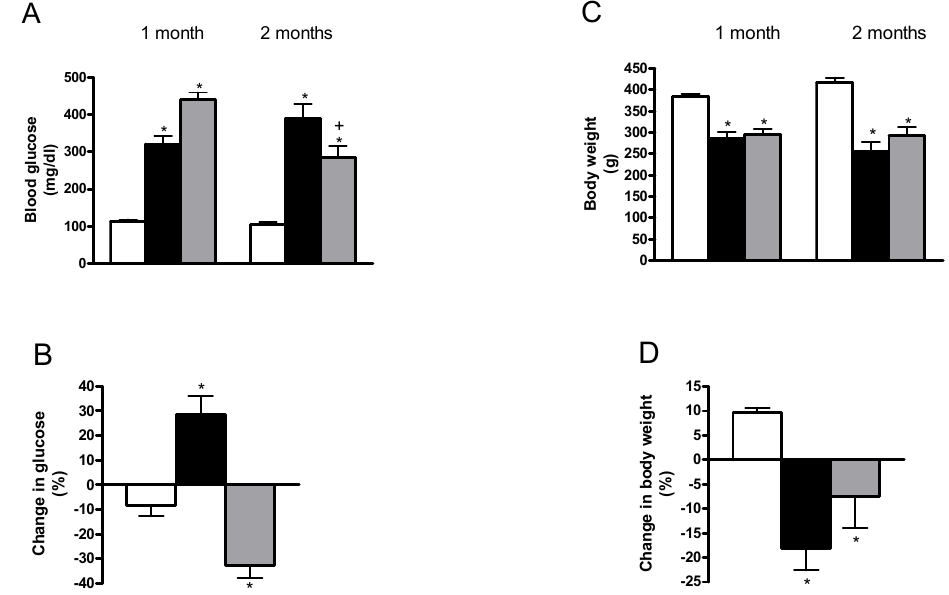
Figure 1. Comparisons of blood glucose ( A , B ) and body weight ( C , D ) for the control, untreated diabetic and allicin-treated diabetic groups. White bars, black bars and grey bars indicate the control, untreated diabetic and allicin-treated diabetic groups, respectively. Data represent the average of values from all the animals ( n = 6) in a given group ± standard error of the mean (SEM) (* p < 0.05 vs. the control group; + p < 0.05 vs. the diabetic groups).